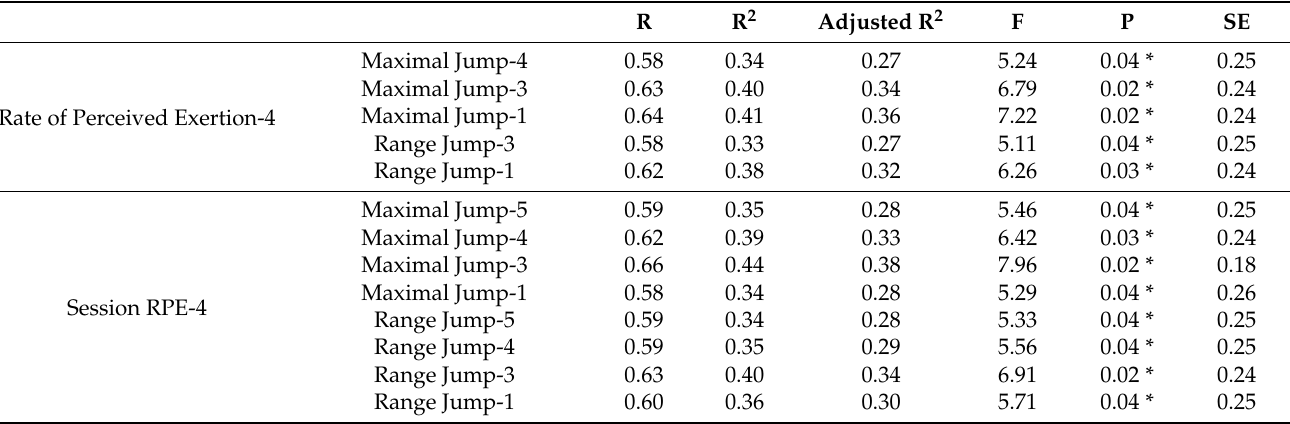
* Denotes significance at p <